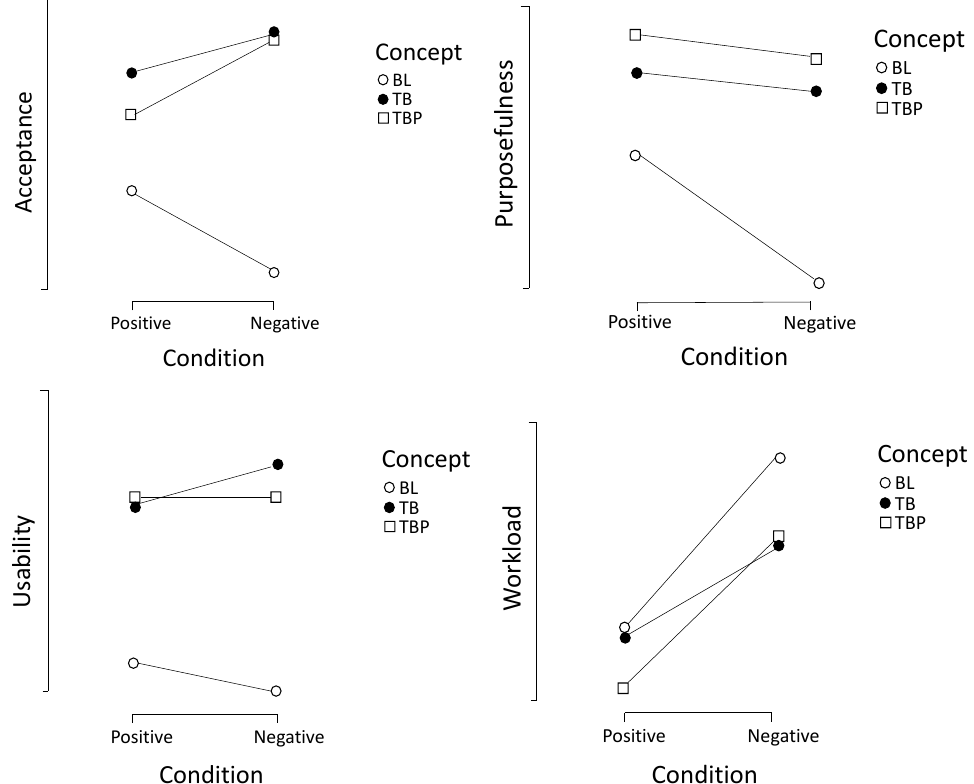
Figure 5. Interaction diagrams for acceptance, usability, workload, and purposefulness of activation behavior.